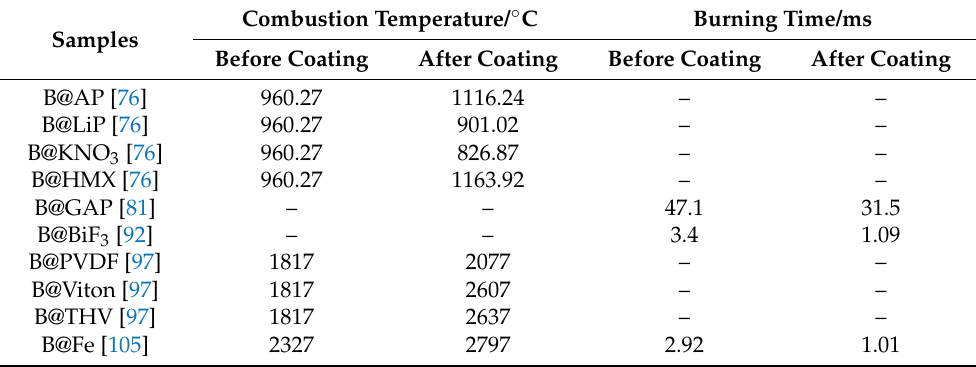
Table 3. Combustion temperature and burning time of coated boron powders.